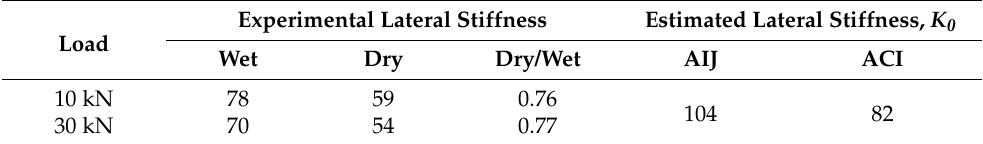
Table 5. Initial lateral structural stiffness K